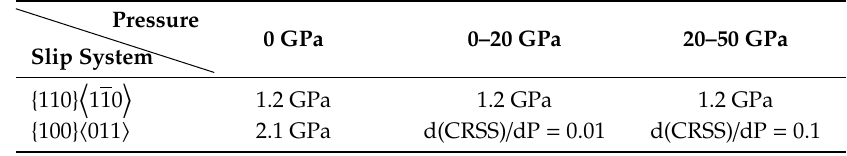
Table 1. CRSSs value used in EVPSC. Values at 0 GPa are the initial CRSSs. A stress exponent of 8 is used for all slip systems.